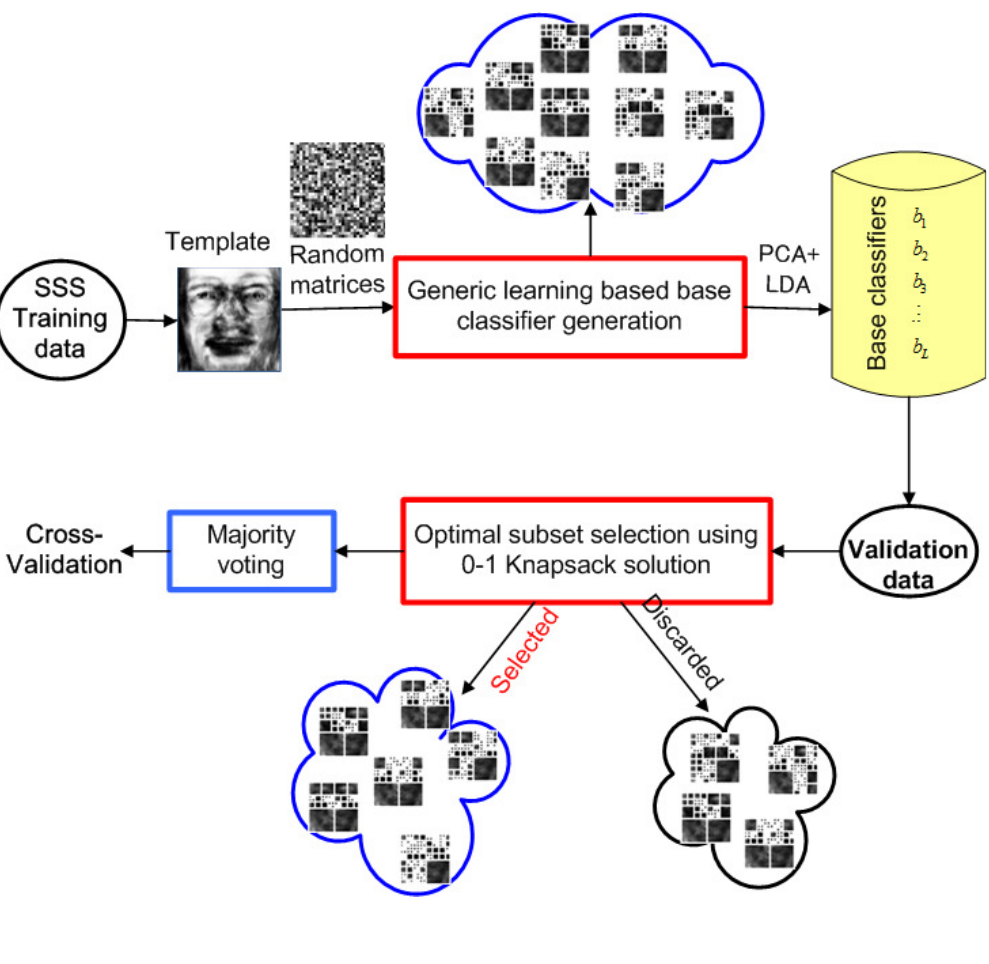
Figure 4. Illustration of the generic learning-based ensemble framework